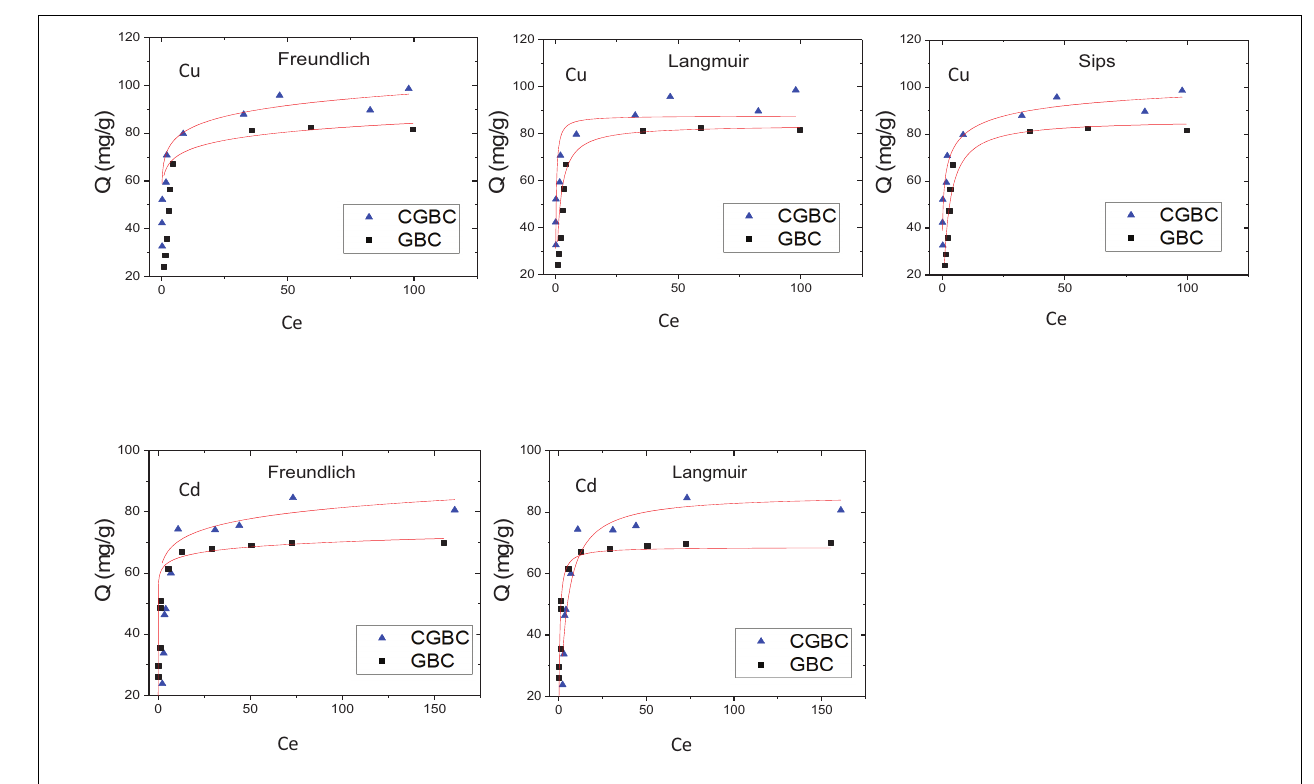
FIGURE 6 | Adsorption isotherms for Cu 2 + and Cd 2 + removal by GBC and CGBC plotted using non-linear least squares curve fitting.